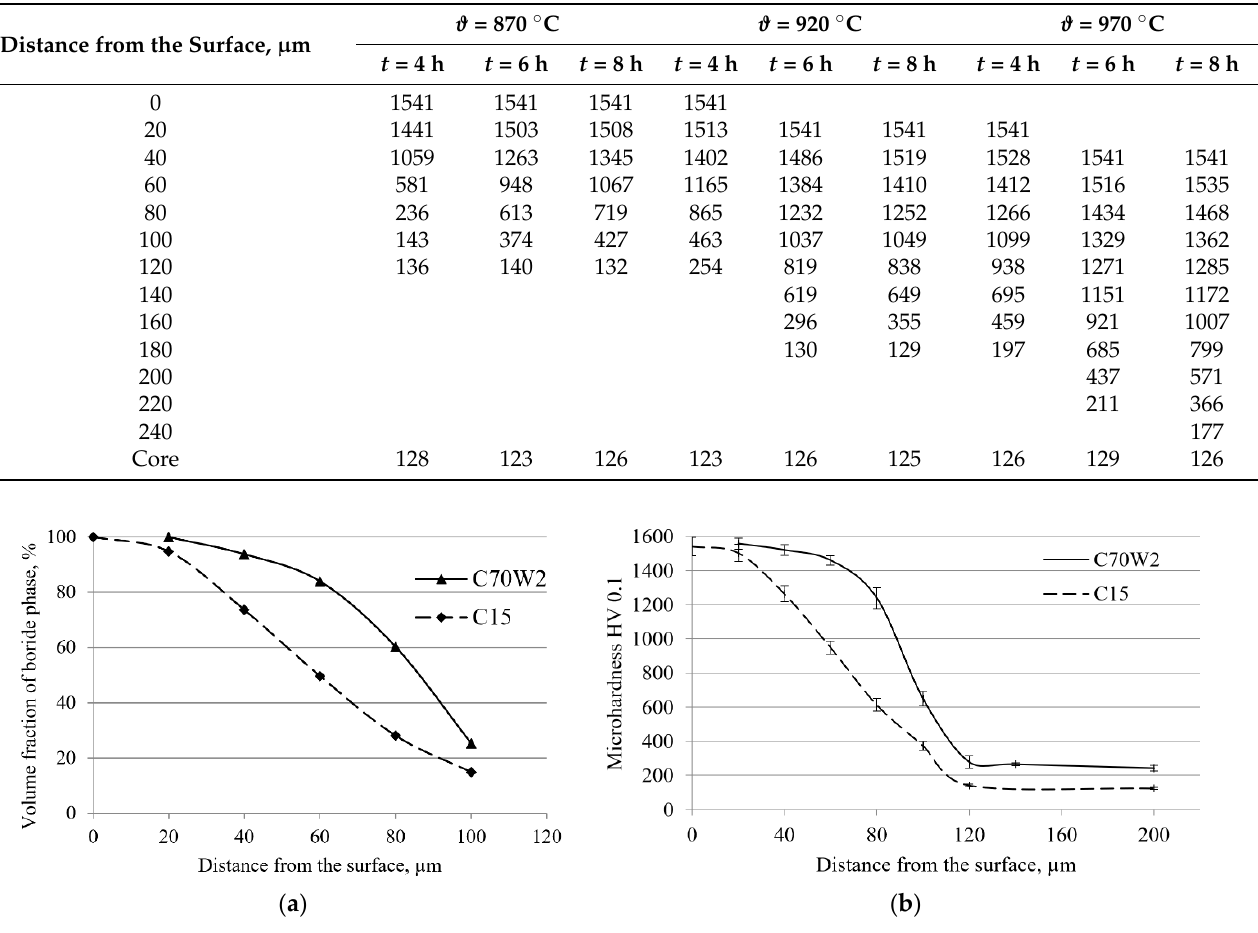
Table 13. Cross-sectional microhardness of the boride layer on C15 steel, HV 0.1.